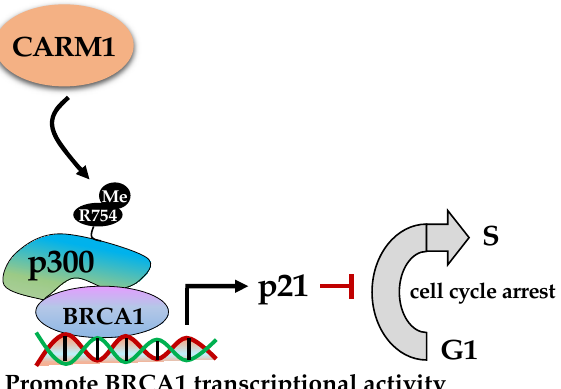
Figure 3. CARM1 methylates p300 to enhance BRCA1 transcriptional activity towards p21, leading to G1 cell cycle arrest upon DNA damage. BRCA1, Breast cancer type 1 susceptibility protein.